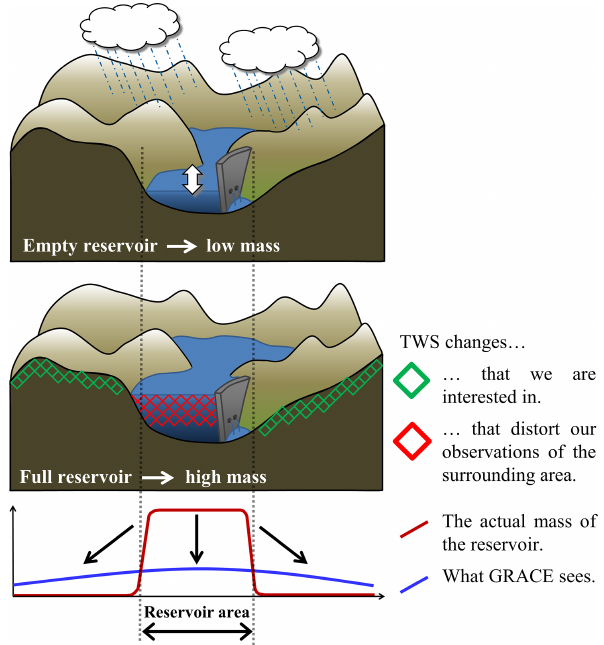
Figure 1. Overview of the lake leakage problem with localized changes in water level of the lake/reservoir influencing the esti- mated water storage in surrounding